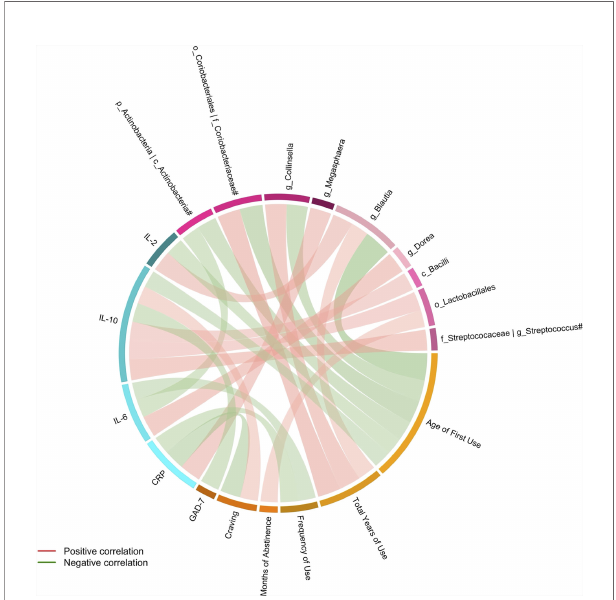
FIGURE 3 | Connections between altered fecal microbiota, clinical variables and systemic in fl ammation identi fi ed by Spearman partial correlation. Adjusted for age, BMI, AUDIT score, and FTND score. Only signi fi cant correlations with an FDR q value < 0.05 were shown. # The taxa showed the same relative abundance at both taxa levels. c, class; o, order; f, family; g, genus; CRP, C-reactive protein; IL, Interleukin; GAD-7, General Anxiety Disorder